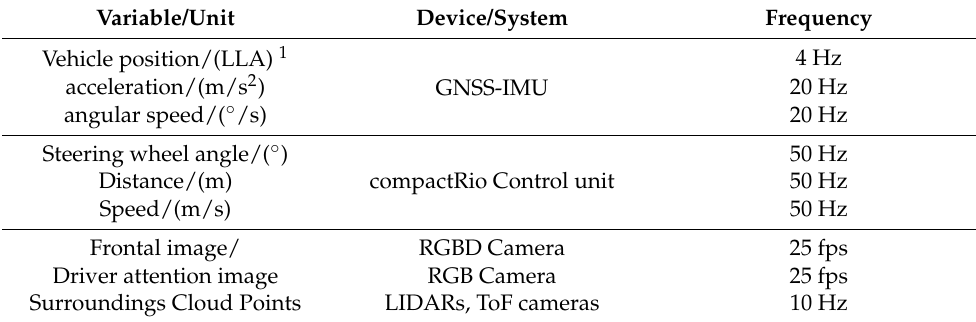
Table 2. CICar. Sensor